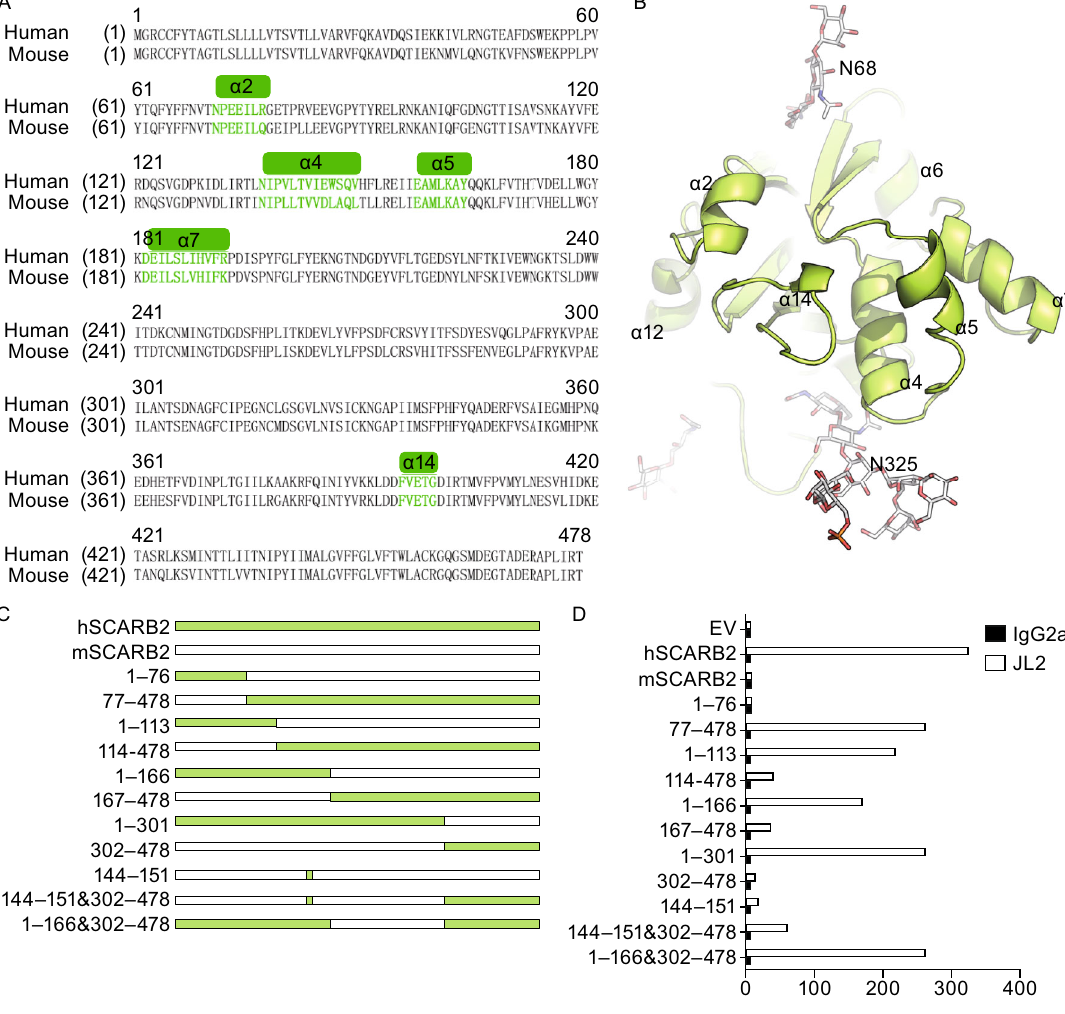
Figure 3. Binding site mapping of JL2 and human SCARB2. (A) An alignment of the mouse and human SCARB2 with the sequences of the 5 α -helices in the apical region highlighted. (B) The structure of the 5 α -helices in the apical region of human SCARB2 at neutral pH. (C) The sketch map of the SCARB2 chimeras. The numbers represent the amino acid sequences of human SCARB2 in the chimeras. (D) 293-SCARB2-KO cells transfected with SCARB2 chimeras were stained by JL2 (open bars) or the isotype control ( fi lled bars). The data shown are representative of 3 independent